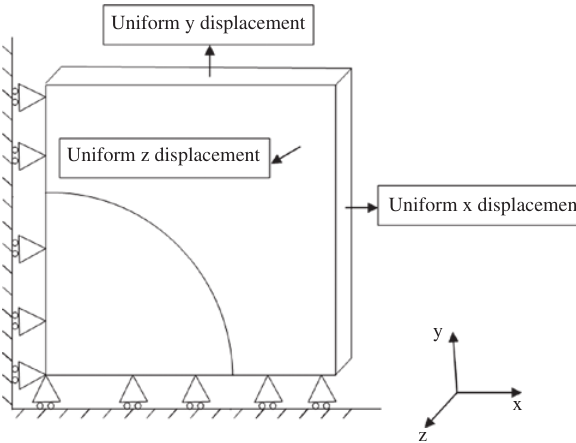
Figure 1: Selected RVE for the analysis and related periodic bound- ary